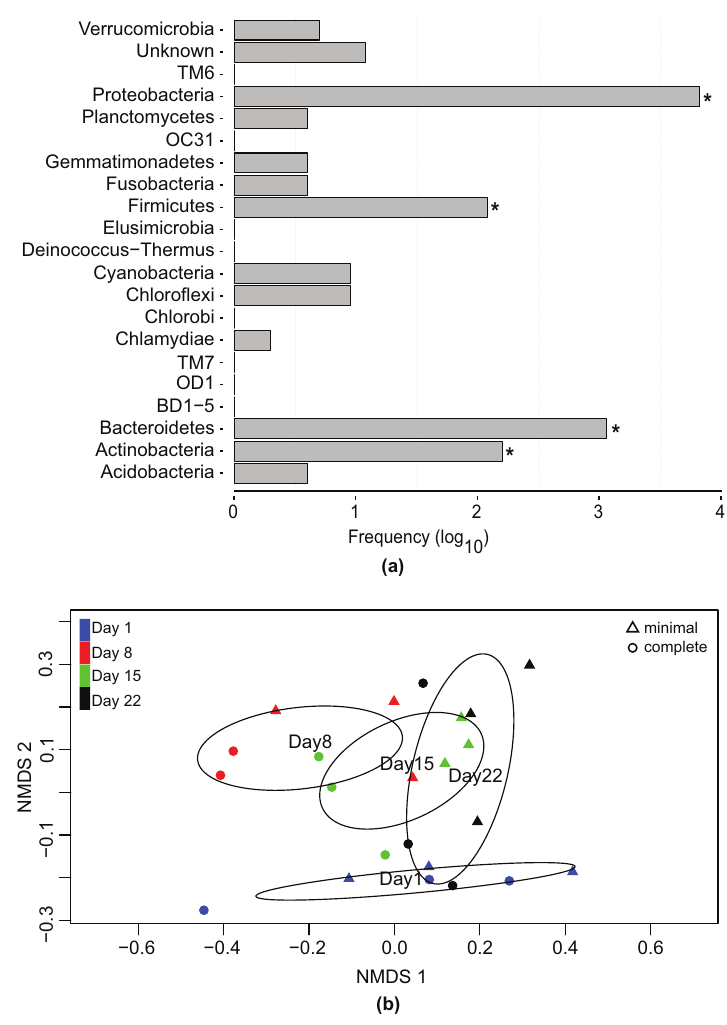
Figure 1. ( a ) Distribution of Operational Taxonomic Unit (OTU) abundance (LOG scaled) within phyla from complete data set. The bins marked with asterisks (*) correspond to 99.97% of all which belong to Proteobacteria, Bacteriodetes, Actinobacteria and Firmicutes. ( b ) Ordination plot of bacterial community in the two media conditions for all sampling points. Triangles and circles correspond to minimal media and complete media conditions, respectively. Blue represents day 1. Red day 8. Green day 15. Black day 22. The ellipses correspond to the 99% confidence interval to each group